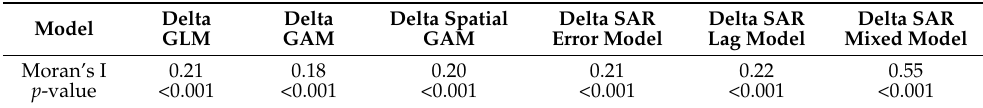
Table 2. Moran’s I value of residuals of the six delta models fitted to NEAMAP weakfish survey data.